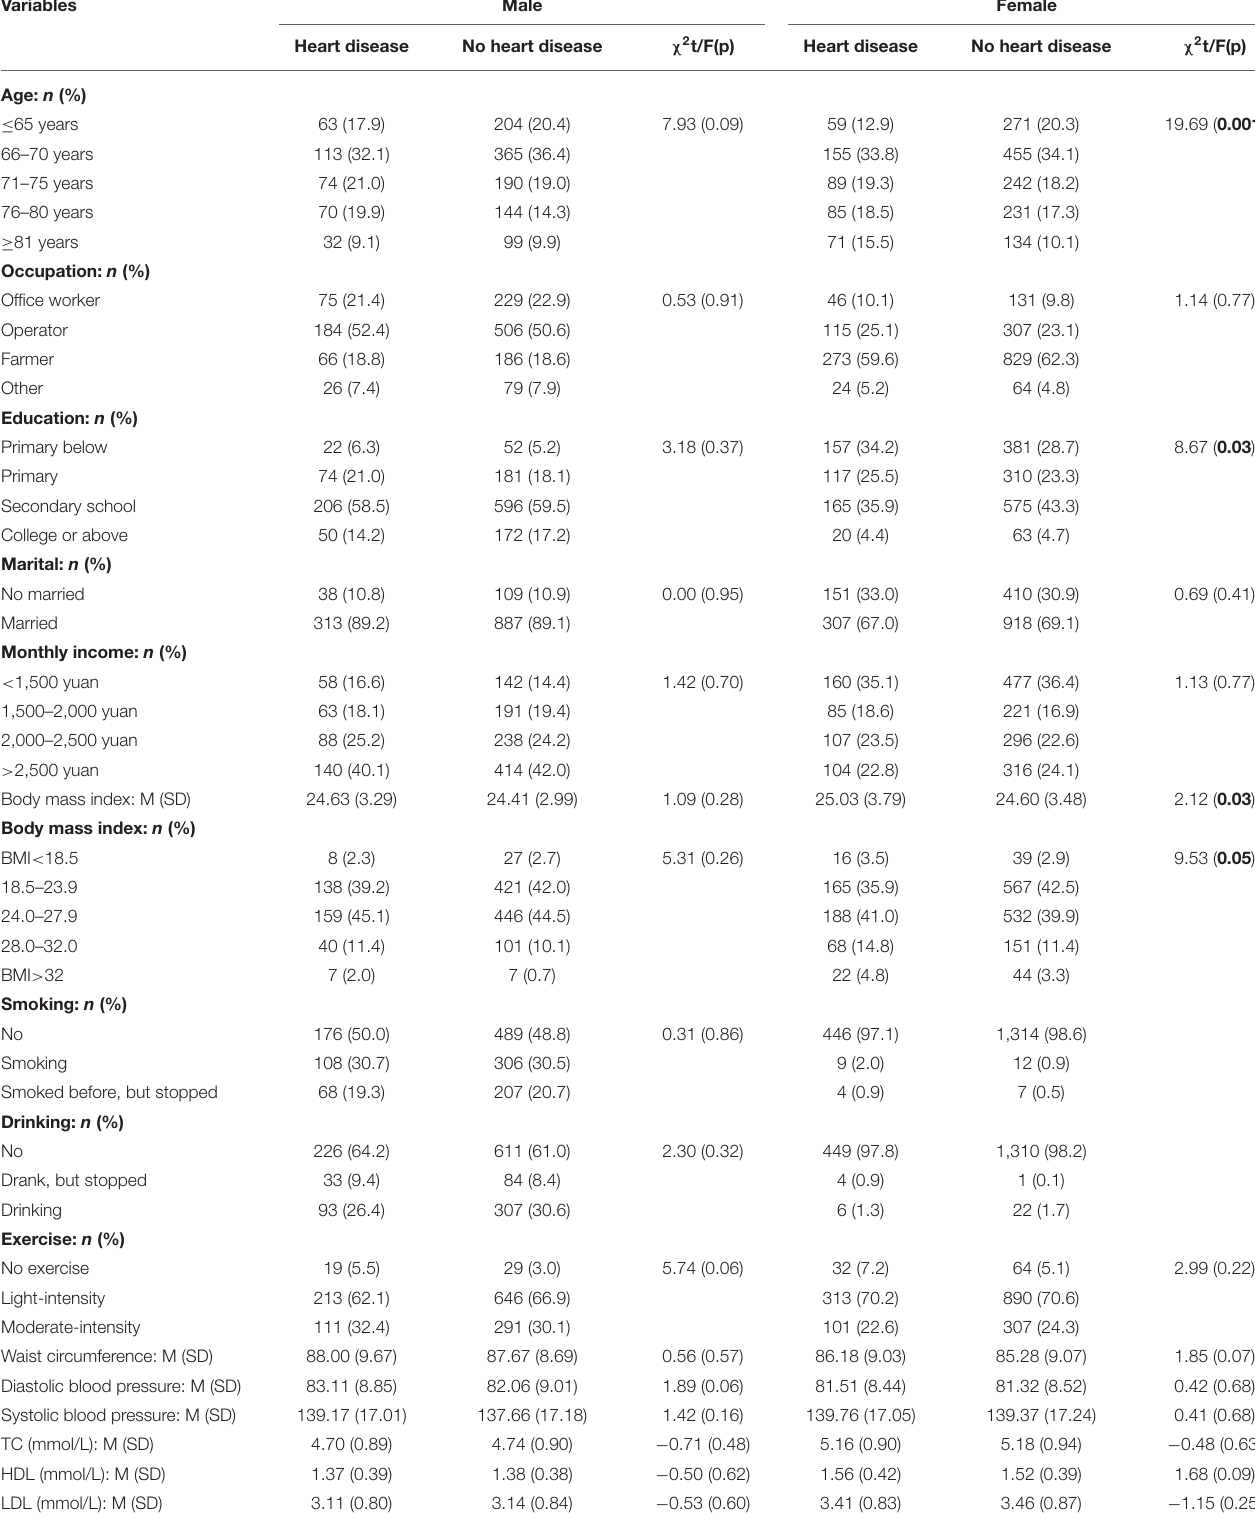
TABLE 1 | Comparison of baseline characteristics among subjects by disease (2013). Variables Male Female Heart disease No heart disease χ 2 t/F(p) Heart disease No heart